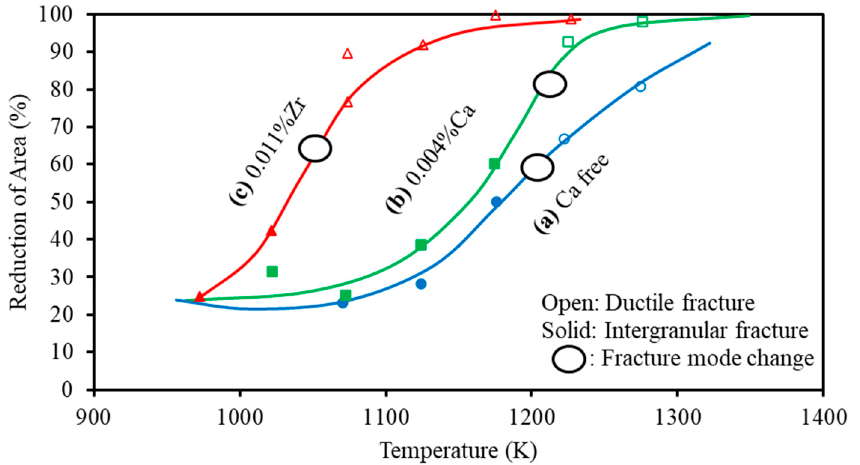
Figure 19. Relationship between tensile temperature and reduction in area for steel with a base composition of ~0.1% C, 0.15% Si, 1.4% Mn, 0.01% Ti, 0.0017% B, < 0.0001% P, 0.003% S, 0.005% N, and 0.011% Al, ( a ) Ca-free, ( b ) 0.004% Ca, and ( c ) 0.011% Zr [47]. The symbol O on the curves marks the changeover from intergranular failure to ductile failure.